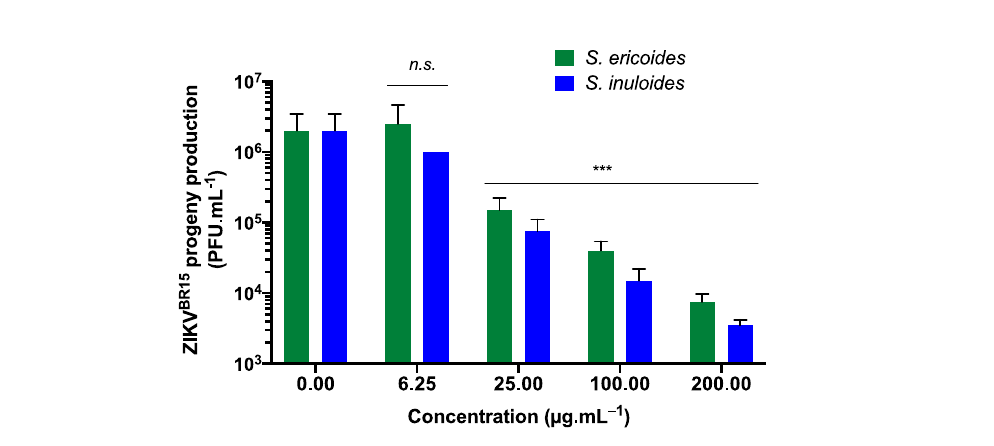
Figure 2. S. ericoides and S. inuloides prevent infection of A549 cells by epidemic strains of ZIKV. Human A549 cells were infected with the contemporary Brazilian ZIKV strain (ZIKV BR15 ) at an MOI of 1 and continuously incubated with different concentrations of Stenocline extracts for 24 h. The plaque-forming assay was used to measure progeny production by ZIKV BR15 . Data represent the means ± SD from three independent experiments. A one-way ANOVA and Dunnett’s test were used for statistical analysis (n.s. = not significant, *** p < 0.001).